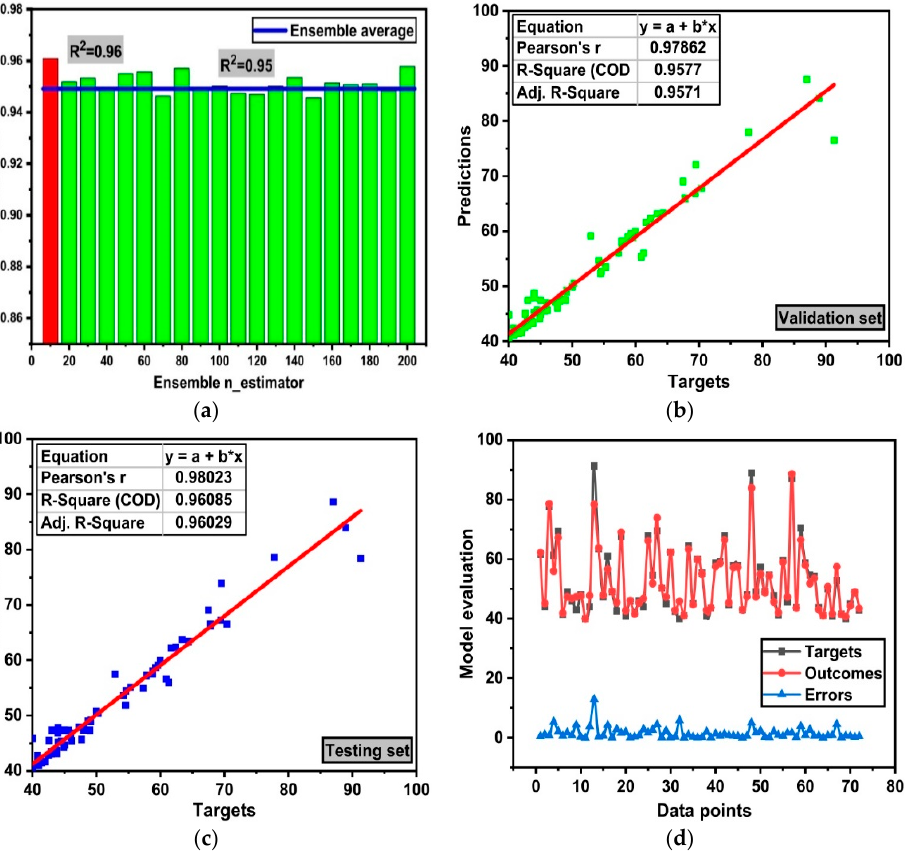
Figure 2. Model evaluation ( a ) Ensemble model with 20 submodels; ( b ) validation based on RF; ( c ) testing based on RF; ( d ) error distribution of the testing set.